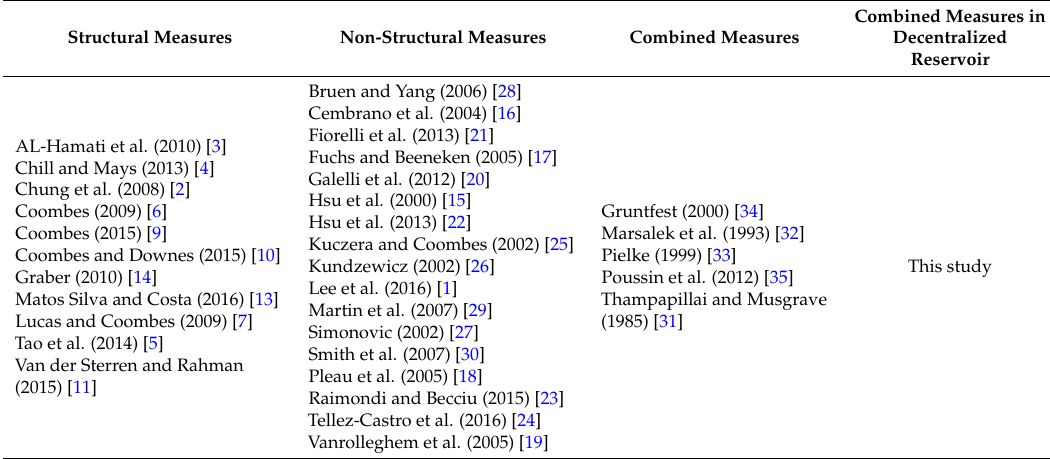
Table 1. Classification of the measures employed by previous studies to reduce inundation in urban drainage